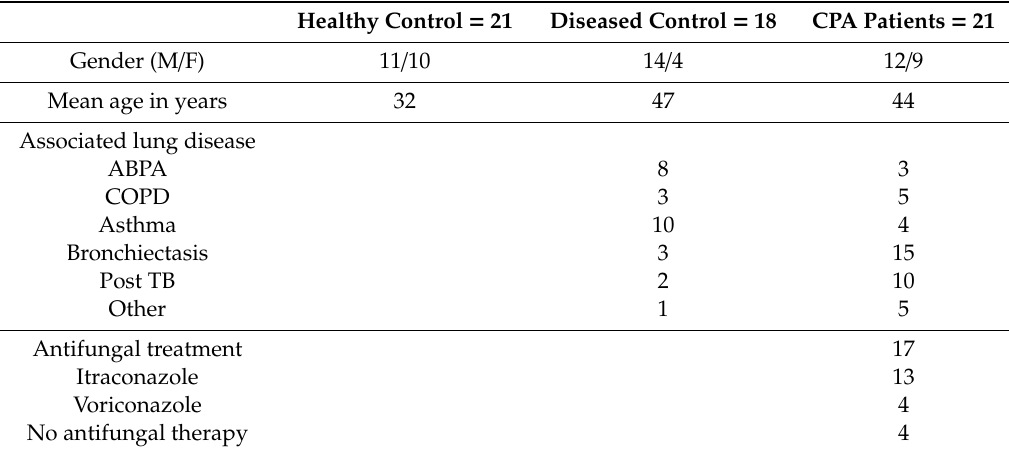
Table 1. Description and clinical data of study participants.